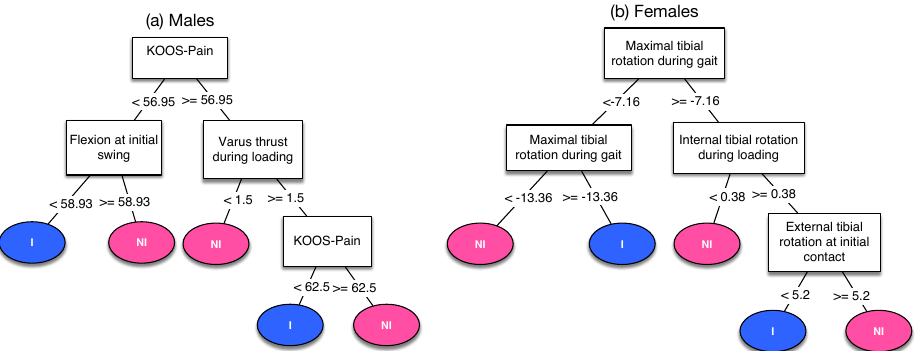
Figure 5. Decision trees for each of the prediction models ( a ) Males and ( b ) Females. All features (ex- cept for KOOS pain score) are expressed in degrees. Female prediction model: external(+)/internal( − ) tibia